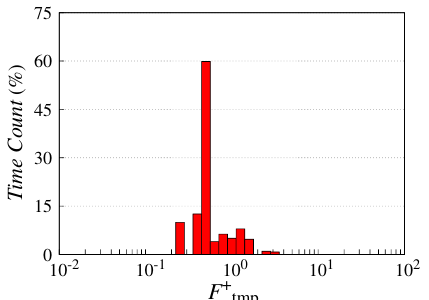
Figure 22. Temporary burst frequency ( F +